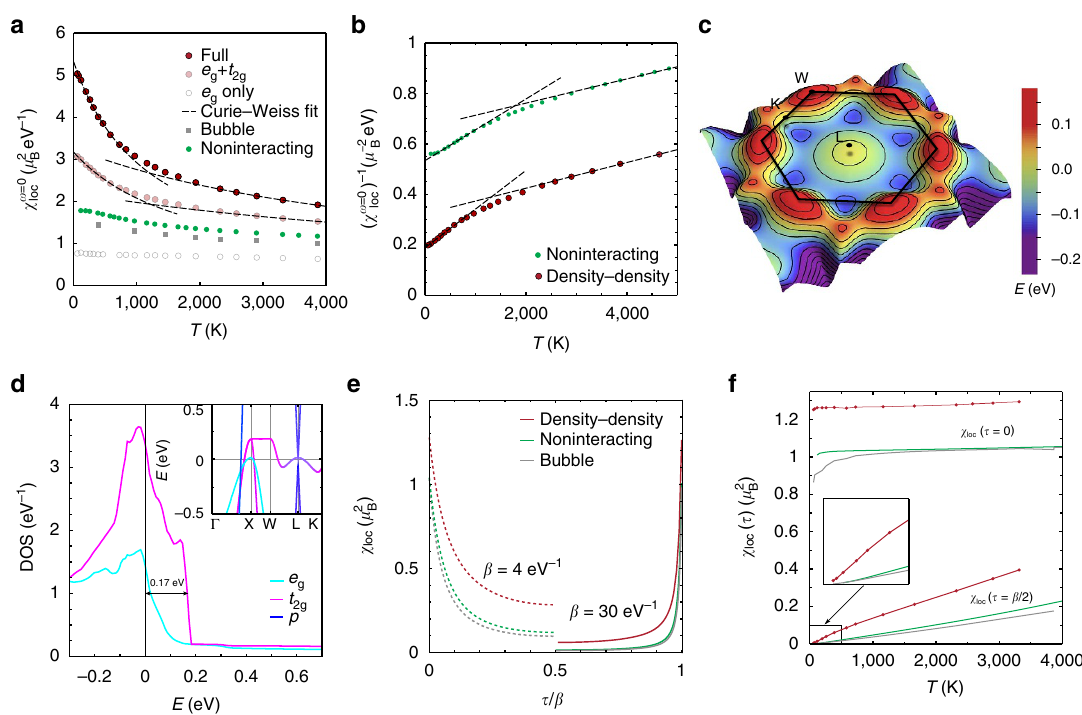
T Þ of nickel loc ð T Þ (‘full’), loc ð